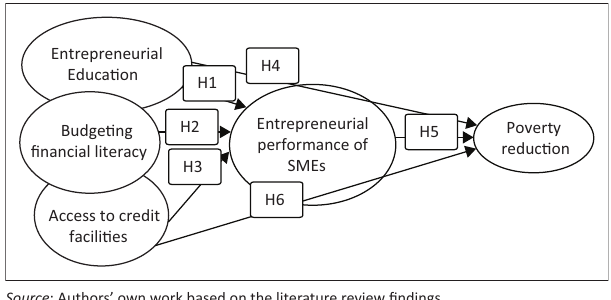
FIGURE 2: Conceptual model for the